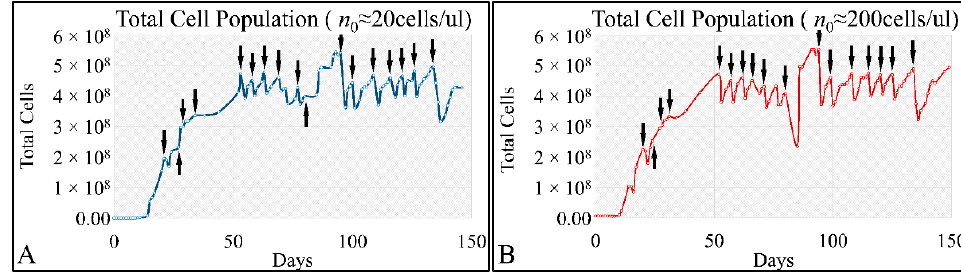
Figure 6. The time-series presentation of the cell population CCRF-CEM with respect to total cell concentration for initial cell populations of ~20 cells/ μ L ( A ) and ~200 cells/ μ L ( B ) ( n 0 : the initial population. The arrows indicate the time-points of cell culture media replacement).